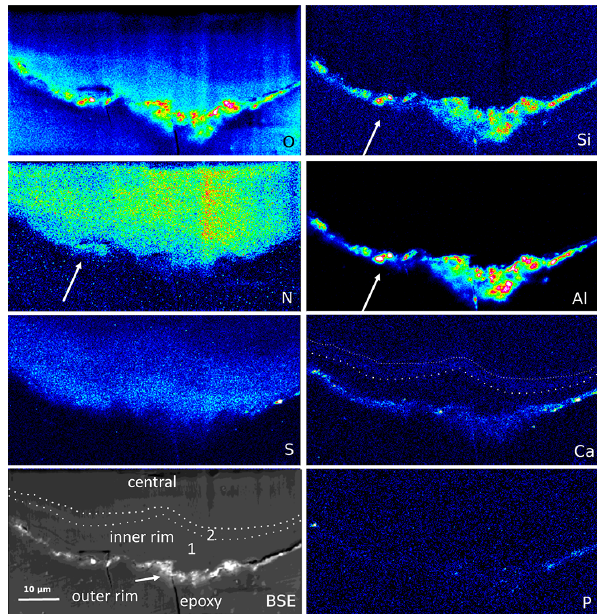
Figure 9. Element distribution (EMPA) of the rim of a large fila- ment. The rim consists of three areas, best visible in the BSE and Ca image: an outer, irregular, and discontinuous rim with enrich- ment of Si–Al–O and Ca, an inner rim 1, poor in Ca, followed by an approximately 1–2µm wide inner rim 2, enriched in Ca (dotted lines). In the outer rim, Ca is also concentrated, together with P and S. N distribution is relatively homogeneous but notably extends up to the outer rim, together with Al–Si (arrows), indicating formation of NH 4 minerals (buddingtonite, tobelite). Vertical stripes are due to beam damage. Scanning conditions: pixel resolution 350 × 180 with pixel size of 200nm and a dwell time per pixel of 200ms; total scan area 70µm ×